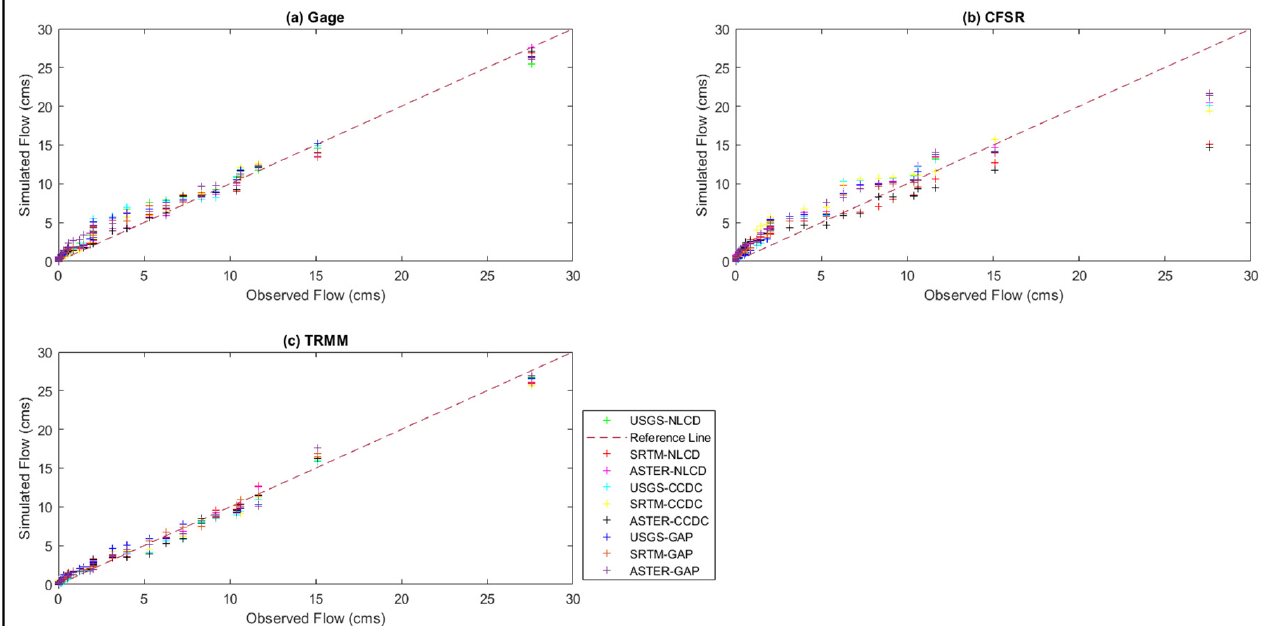
Figure 13. Variation of simulated flows with observed flows was obtained for the three precipitation datasets as ( a ) Gage, ( b ) CFSR, and ( c ) TRMM with nine different combinations for the Peachtree watershed.